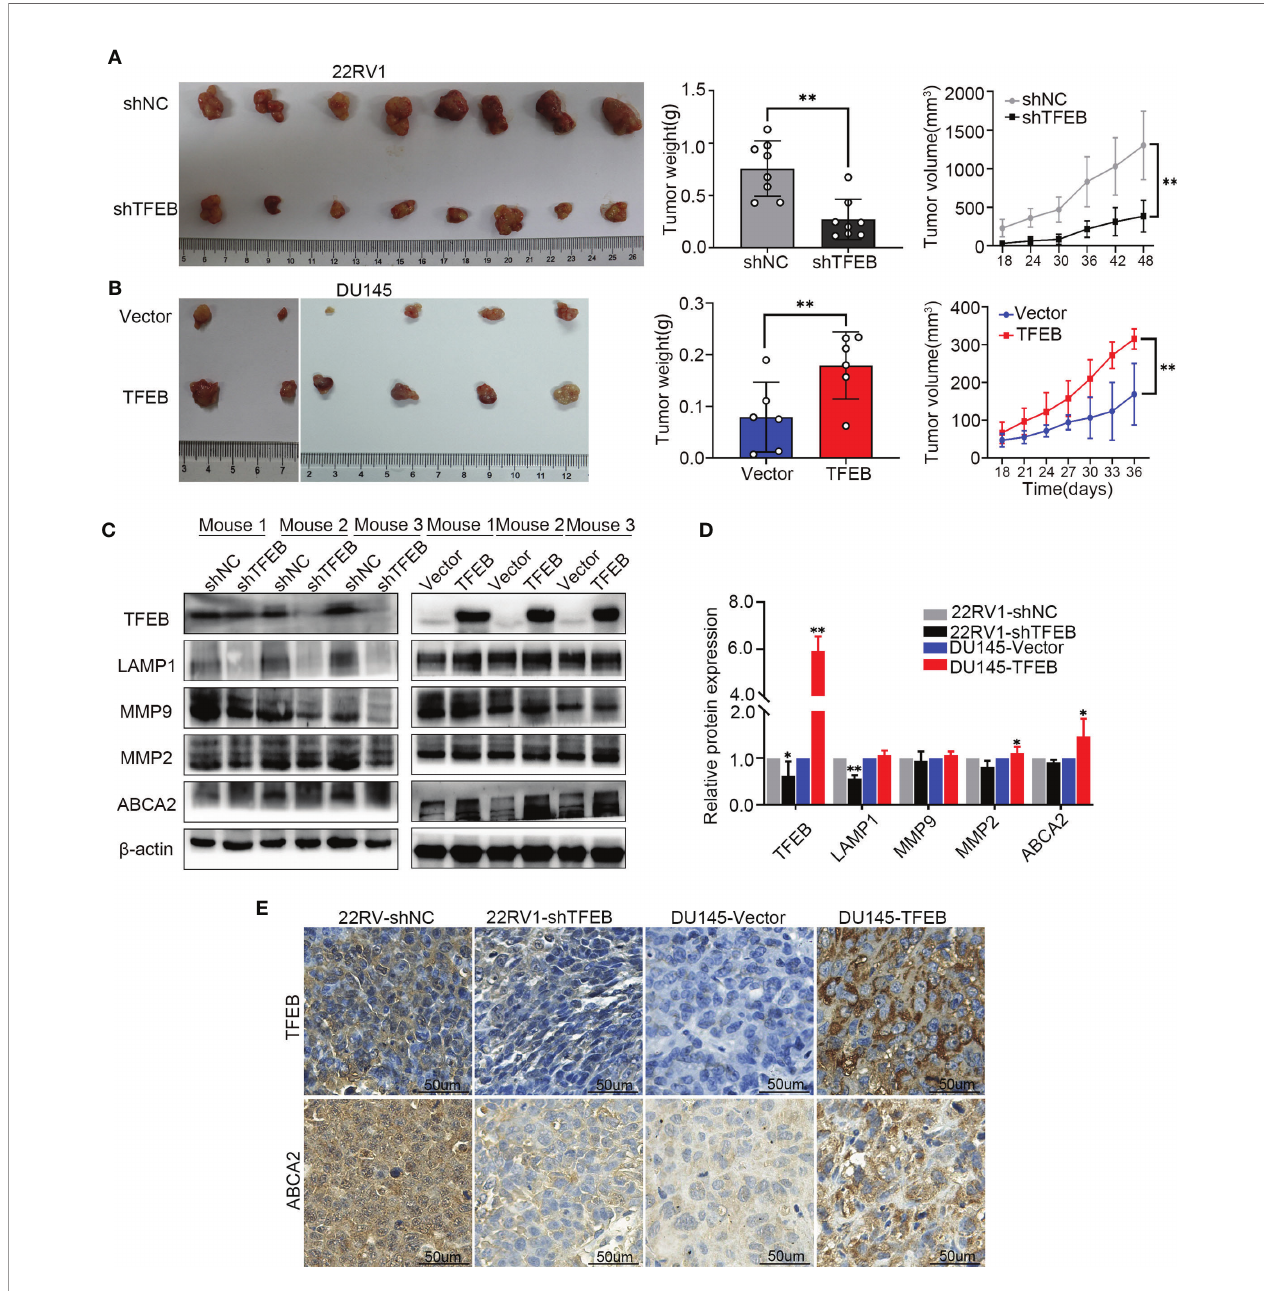
FIGURE 5 | The TFEB xenograft tumor model and the validation of MMP9, MMP2 and ABCA2. (A) Knock-down TFEB expression inhibit PCa growth in 22RV1 xenograft tumor. The upper column is the control group (shNC), and the bottom line is the TFEB knockdown group (shTFEB). The curves of tumor volume and weight are also shown at right panel. (B) Overexpression of TFEB promoted PCa growth in DU145 xenograft model. The upper column is the control group (Vector), and the bottom line is the TFEB overexpression group (TFEB). The curves of tumor volume and weight are also shown at right panel. (C, D) Validation of TFEB, LAMP1, MMP9, MMP2, and ABCA2 protein expression by western-blot. Quantitative analysis of the western-blot from panel (C) . (E) Immunohistochemistry of TFEB and ABCA2 in TFEB knockdown and TFEB overexpressing xenograft tumor samples. Statistical analysis was from three independent experiments and is presented as mean ± SD. * p < 0.05, ** p < 0.01 compared with control